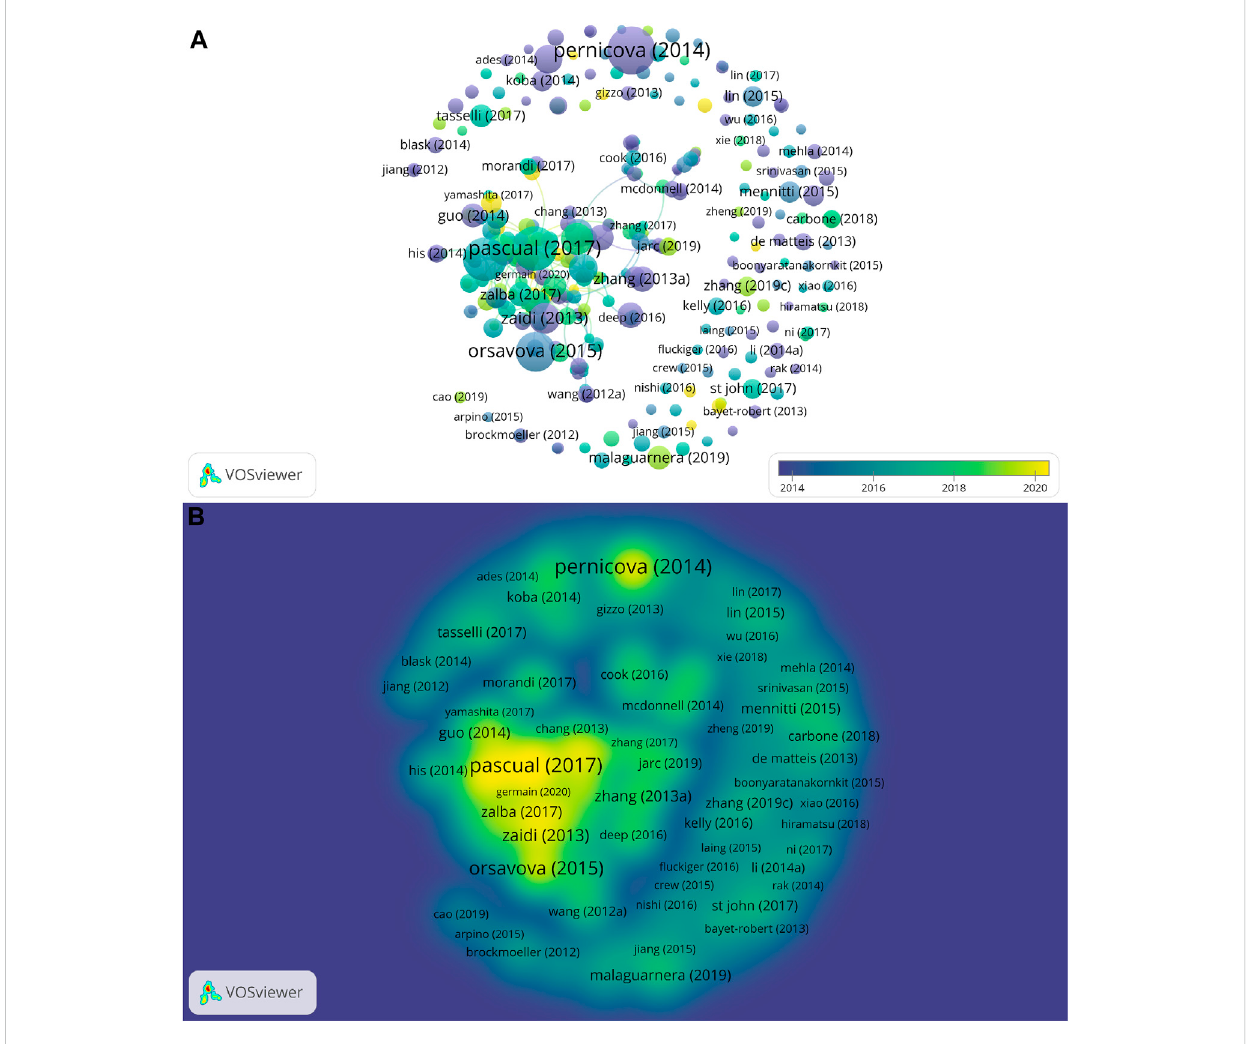
Overlay map and density map of documents with more than 20 citations. (A) Overlay map of documents with more than 20 citations. (B) Density map of documents with more than 20